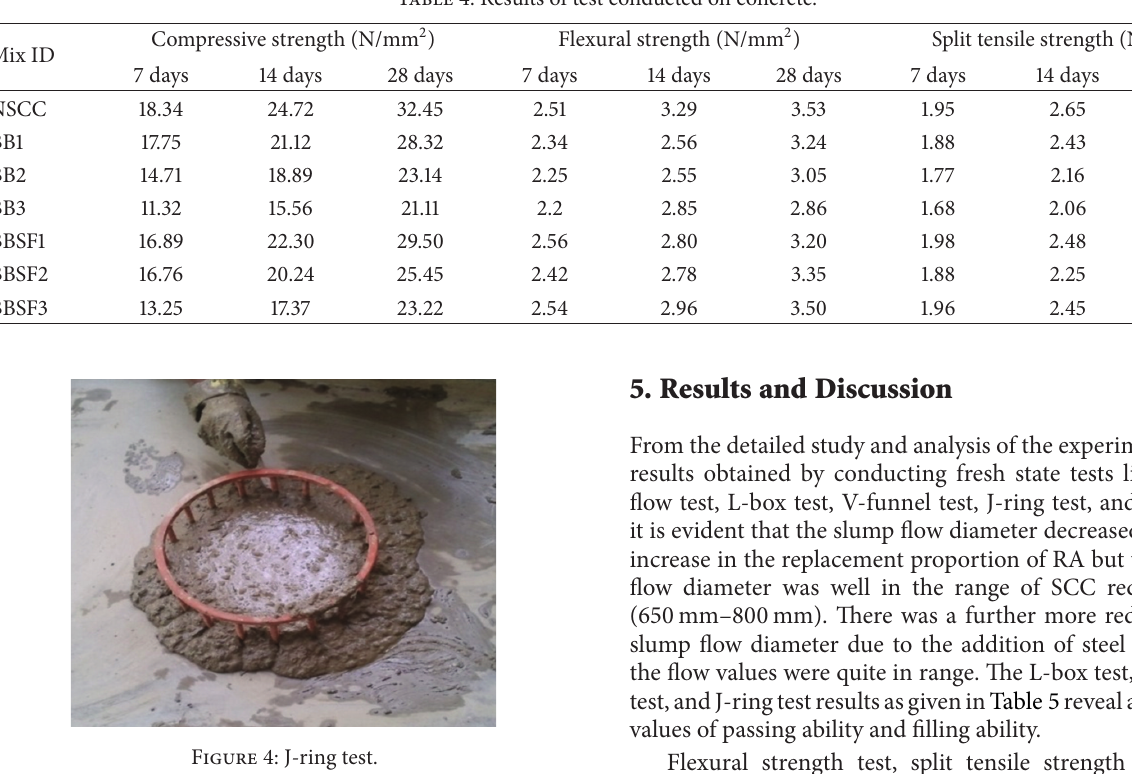
Table 4: Results of test conducted on concrete.